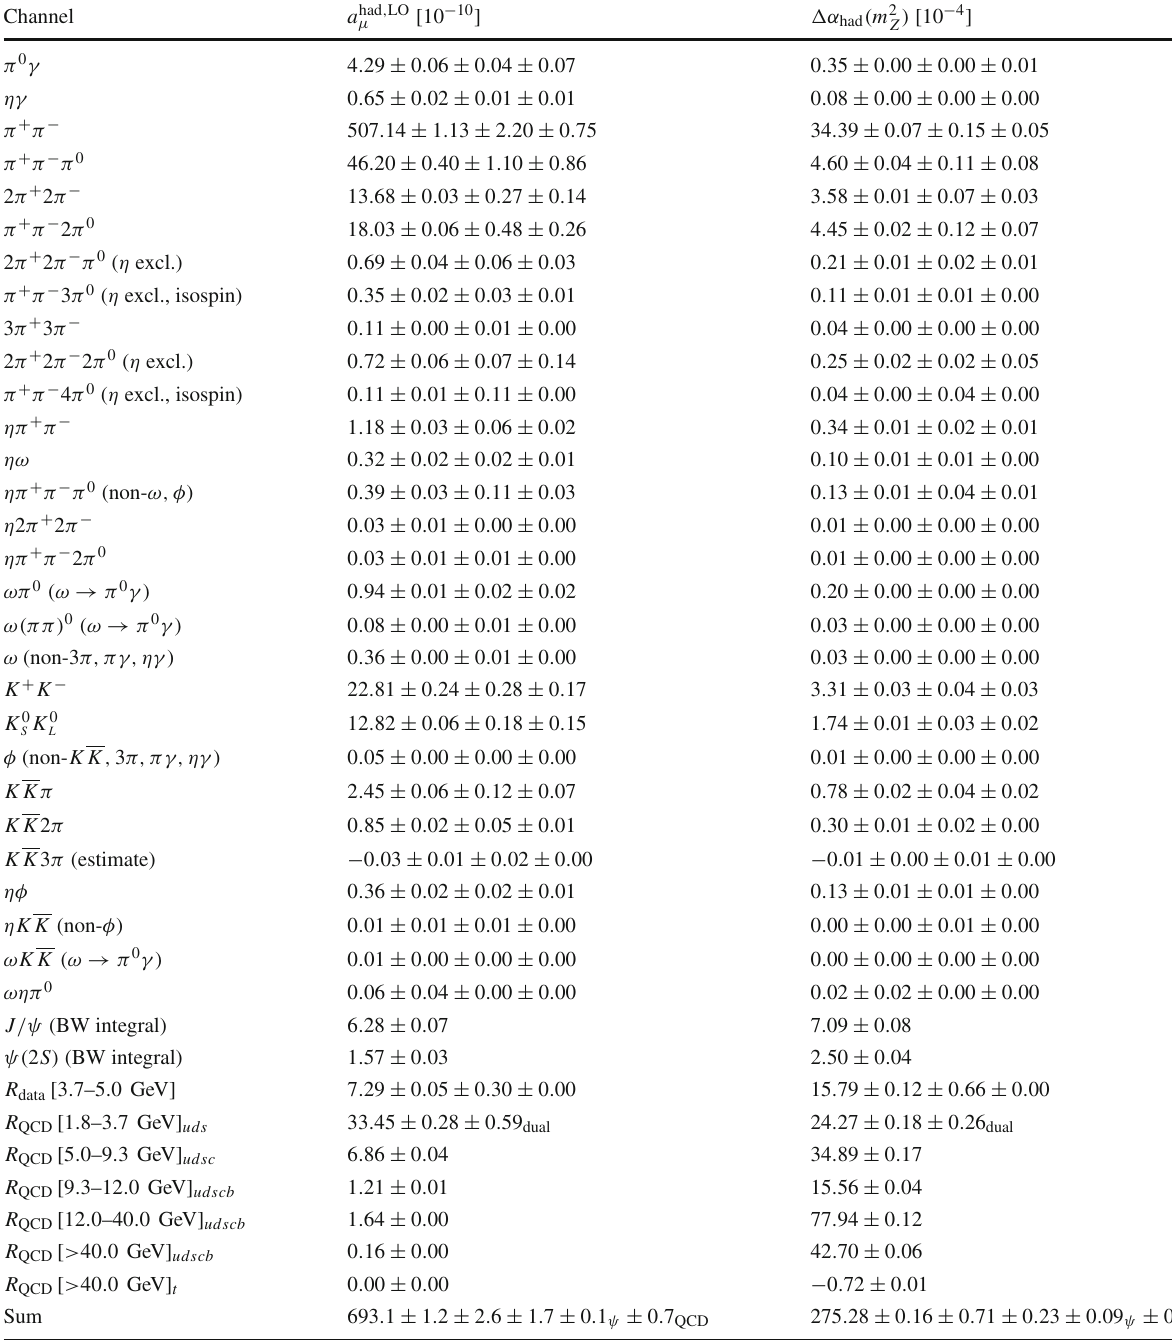
Table 1 Compilation of the contributions to a had , LO μ and (cid:6)α had ( m 2 as obtained from HVPTools. Where three (or more) uncertainties are given, the first is statistical, the second channel-specific systematic, and the third common systematic, which is correlated with at least one other channel. For the contributions computed from QCD, only total uncer- tainties are given, which include effects from the α S uncertainty, the truncation of the perturbative series at four loops, the FOPT vs. CIPT ambiguity, and quark-mass uncertainties. Except for the latter uncer- tainty, all other uncertainties are taken to be fully correlated among